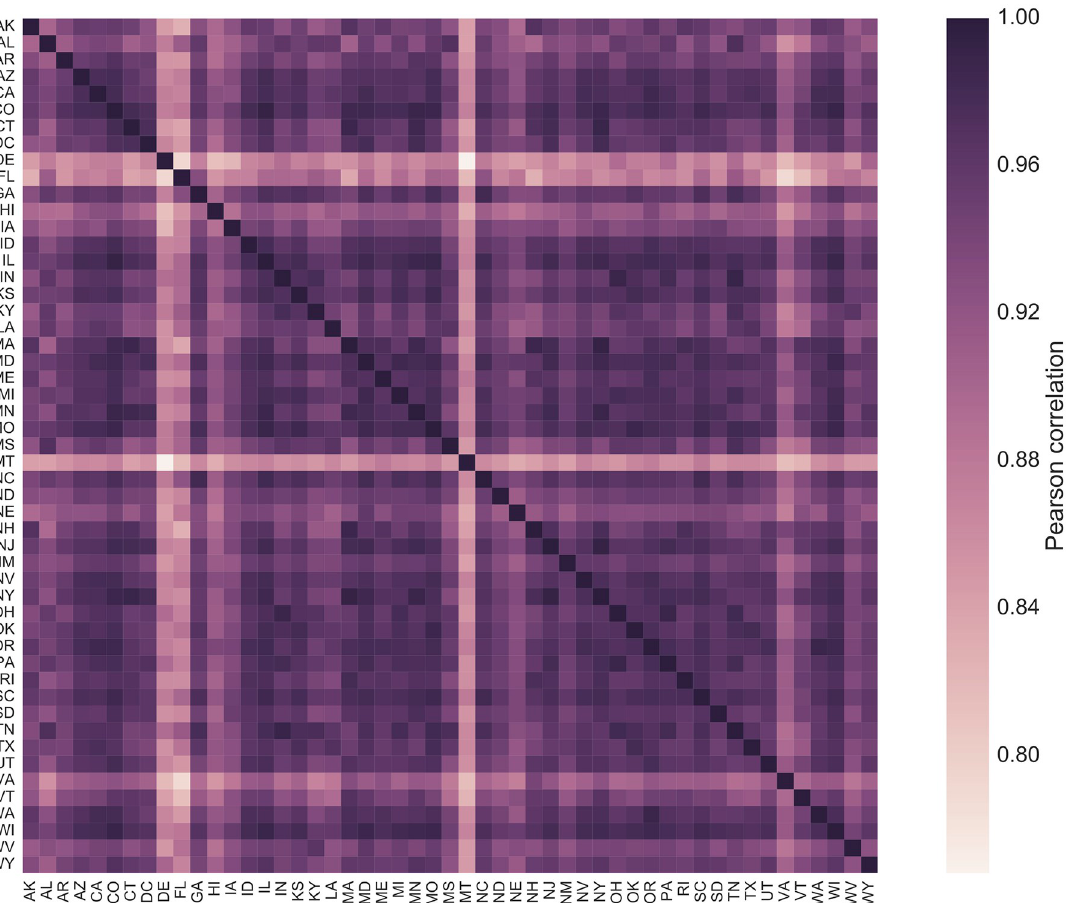
Fig 2. Correlation of public attention timelines by state. Pearson correlation matrix of the daily Wikipedia pageviews time series of the 50 states and the District of Columbia.